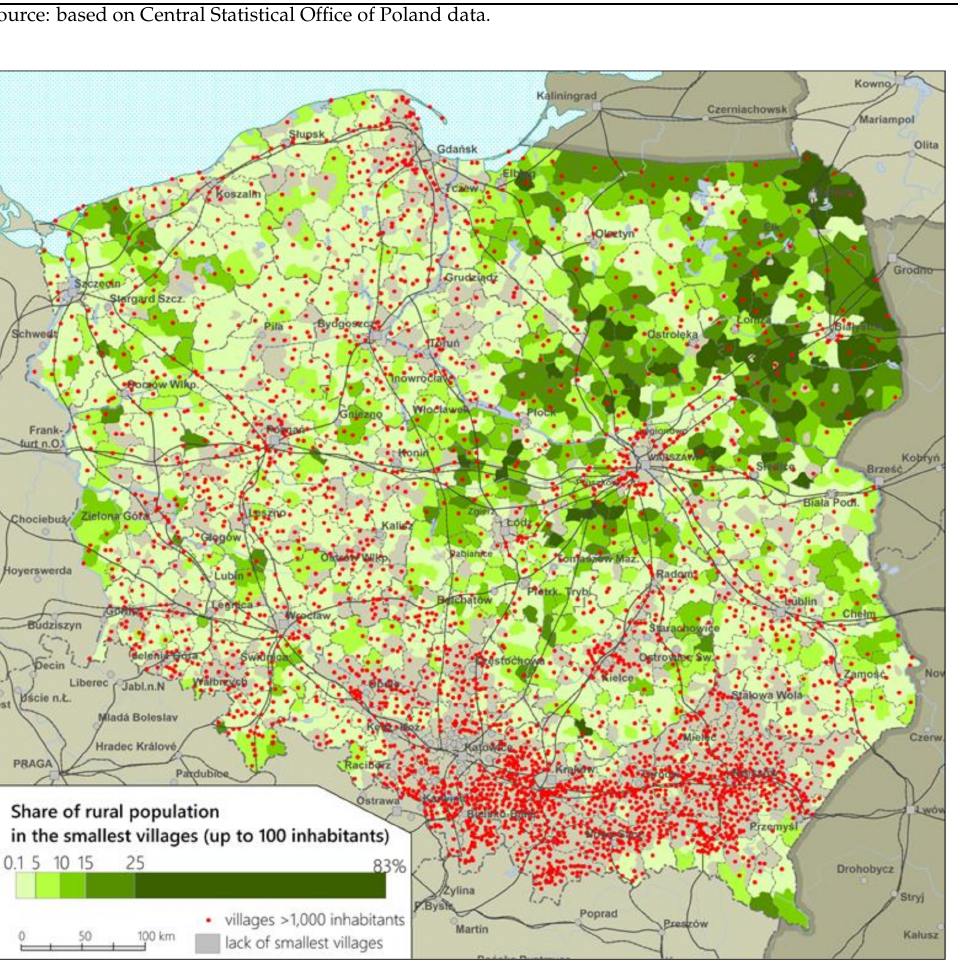
Figure 5. Share of the rural population in the smallest villages (up to 100 inhabitants). Source: based on Central Statistical Office of Poland